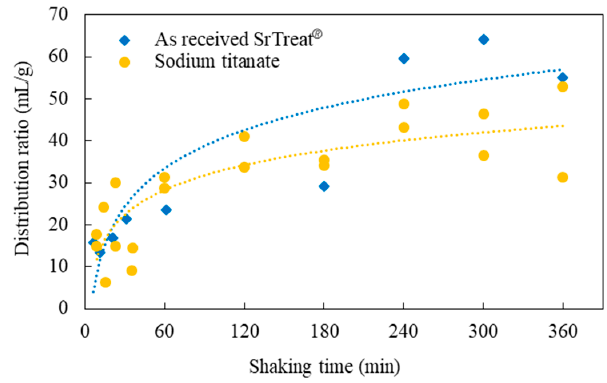
Figure 3. Time dependency of the distribution ratio on basic two titanates.